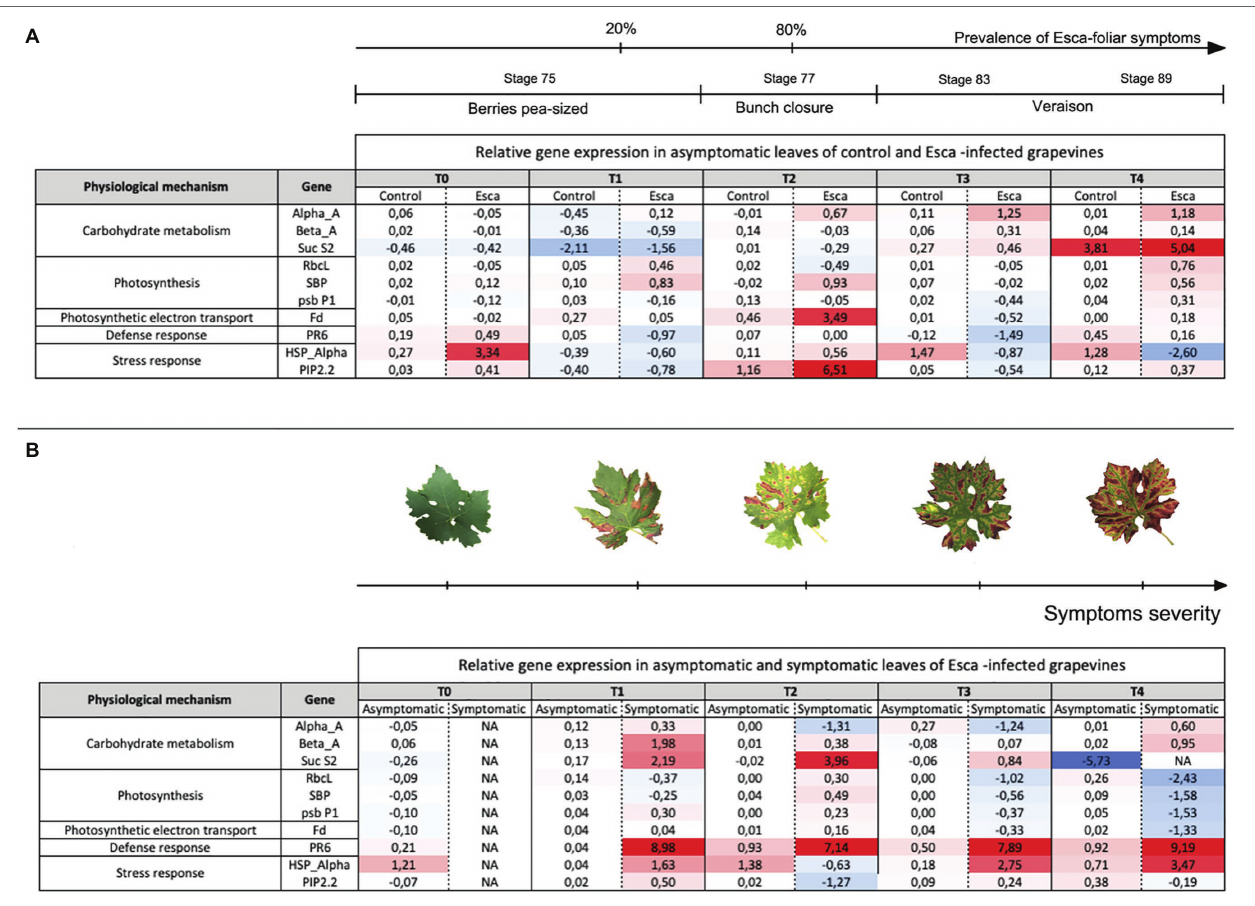
FIGURE 8 | “Heatmap” representing the relative expression levels of 10 targeted genes (in Log 2 transformations) involved in carbohydrate metabolism (three genes), photosynthesis (three genes), photosynthetic electron transport (one gene), defense mechanism (one gene), and stress responses (two genes). (A) Comparison of genes expression levels in asymptomatic leaves sampled from either control or Esca-diseased grapevines, and (B) comparison of genes expression levels in asymptomatic and symptomatic leaves sampled from grapevines that expressed Esca-foliar symptoms. A blue-color gradient represents genes that were repressed (Log 2 (RE) < 0); a red-color gradient represents genes that were over-expressed (Log 2 (RE) > 0), and a white-color gradient represents genes exhibiting no modification in their expression (Log 2 (RE) = 0). Values are means ± SD of two independent biological replicates. Key-growing phenological stages, leaf symptom severity, and the prevalence of Esca appearance are also